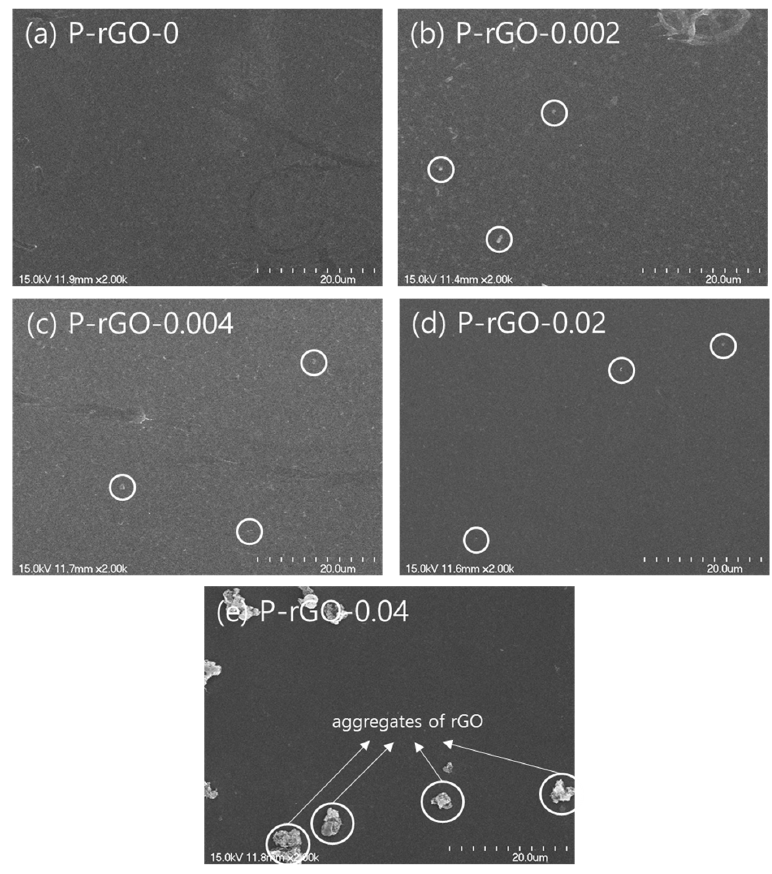
Figure 3. SEM images of ( a ) P ‐ rGO ‐ 0, ( b ) P ‐ rGO ‐ 0.002, ( c ) P ‐ rGO ‐ 0.004, ( d ) P ‐ rGO ‐ 0.02, and ( e ) P ‐ rGO ‐ 0.04 at π = 5 mN/m .